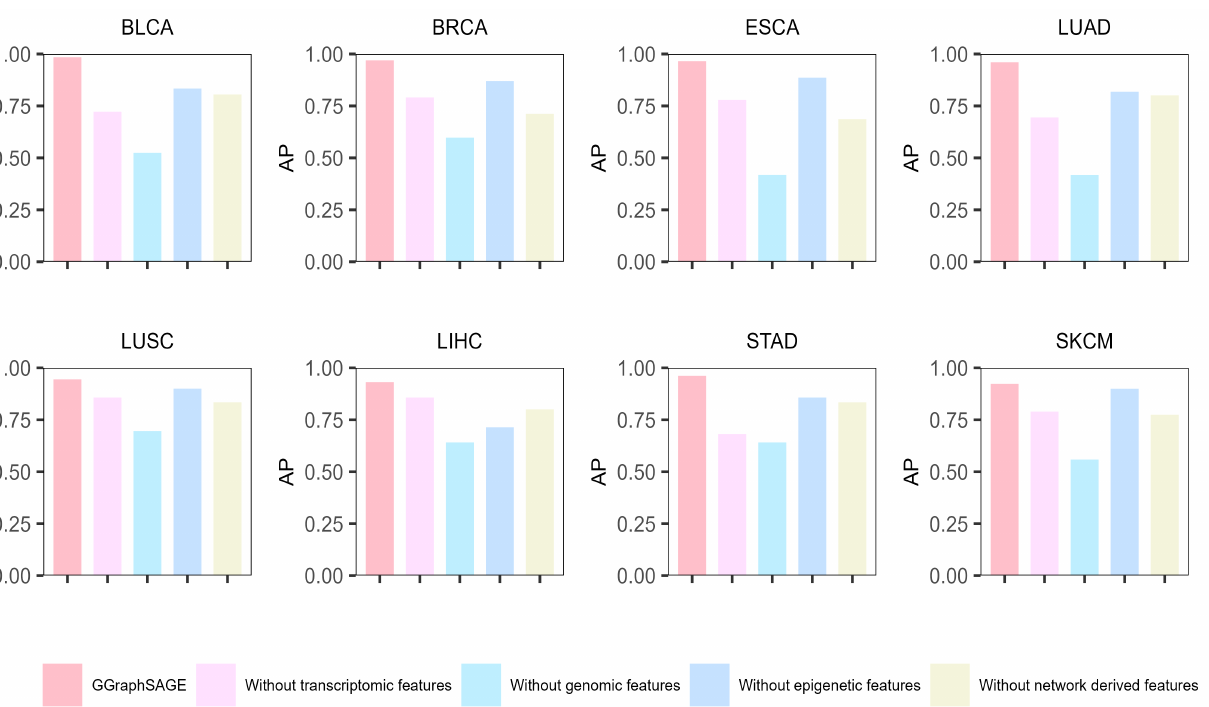
Figure 6. Results of ablation experiment of GGraphSAGE in eight cancer types. The bar chart represents the model performance (AP) of GGraphSAGE across eight cancer types when removing genomic, epigenetic, transcriptome, and network data,